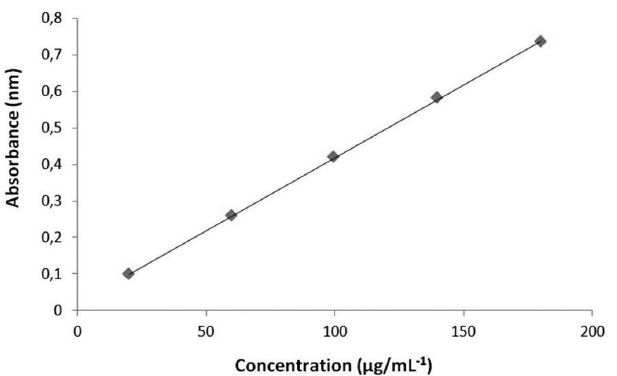
FIGURE 3 – Analytical curve constructed from the absorbance values of